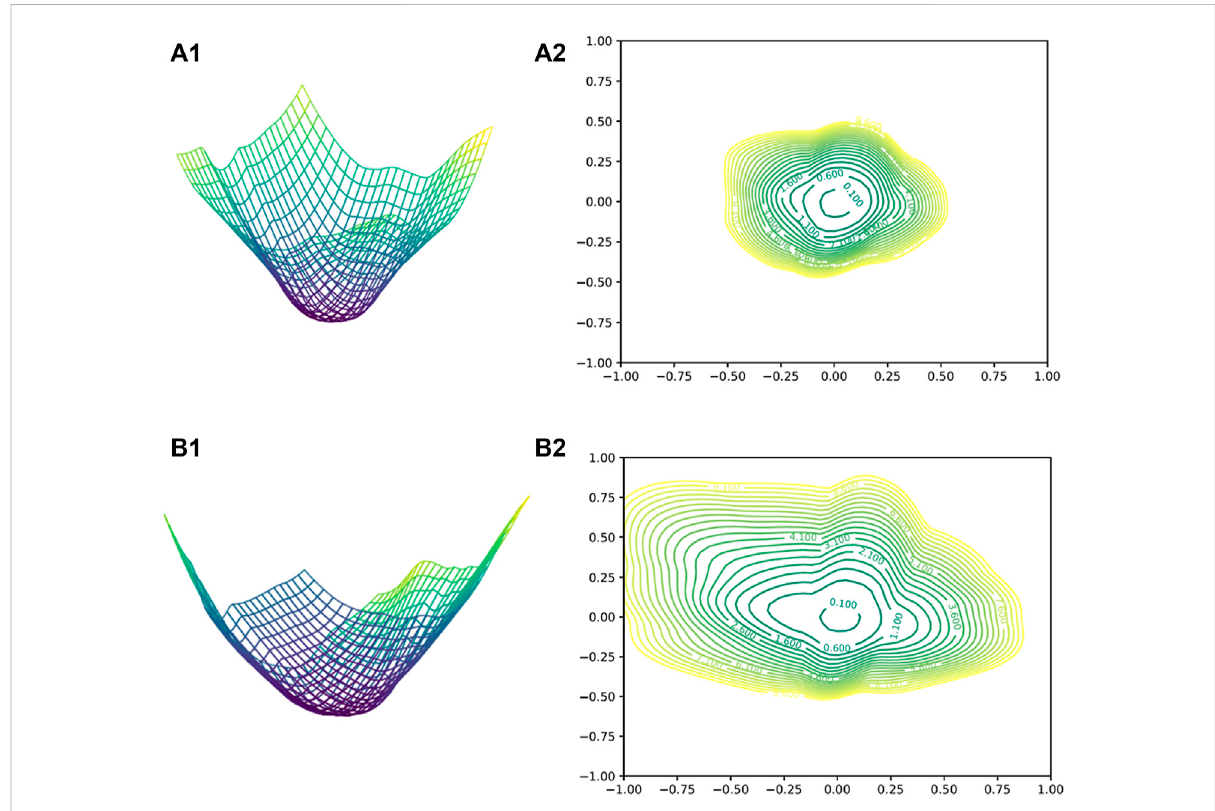
FIGURE 6 Loss landscape visualizations of CNN trained with the full dataset (A1,A2) and the subset with 50% samples of the full dataset (B1,B2) . Left: The surface of the loss landscape. Right: The contour map of the loss landscape, loss = 10.